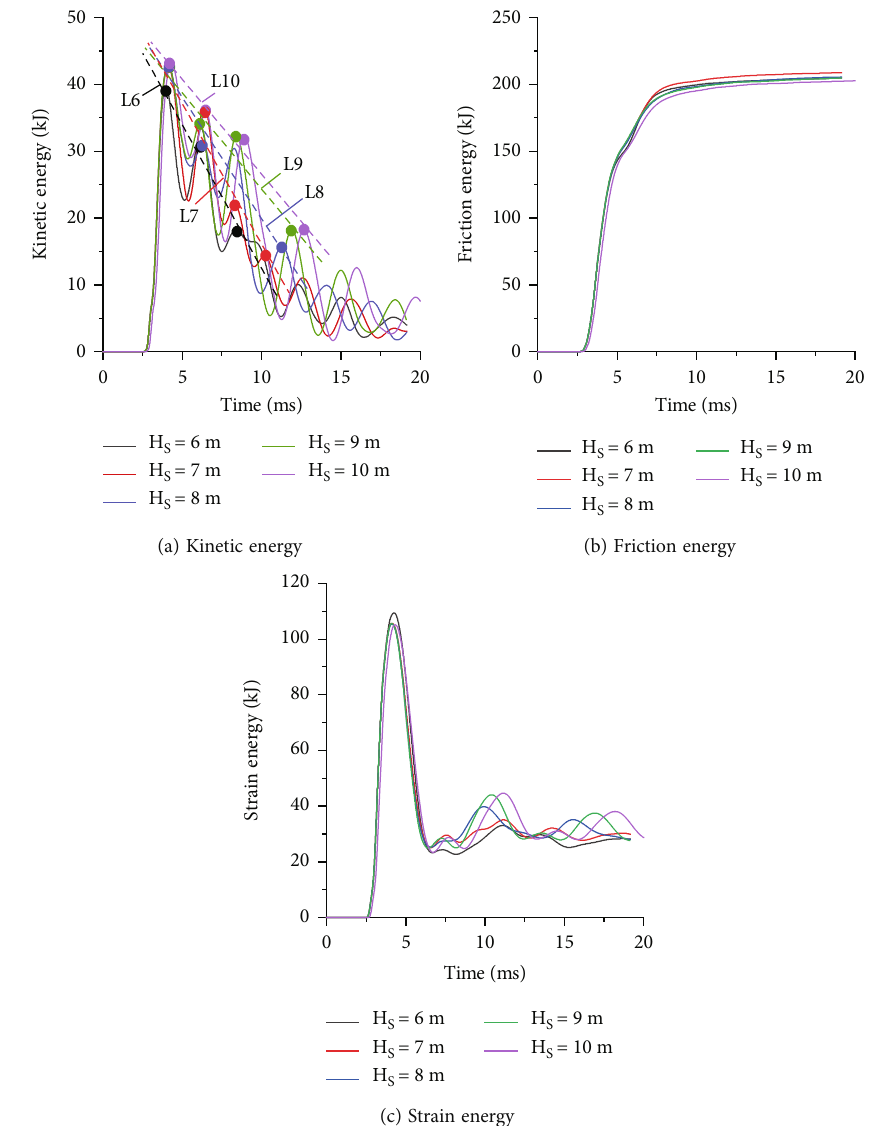
Figure 17: Energy evolution curves (7 ~ 11 working cases). Table 5: Amplitude attenuation values (7 ~ 11 working